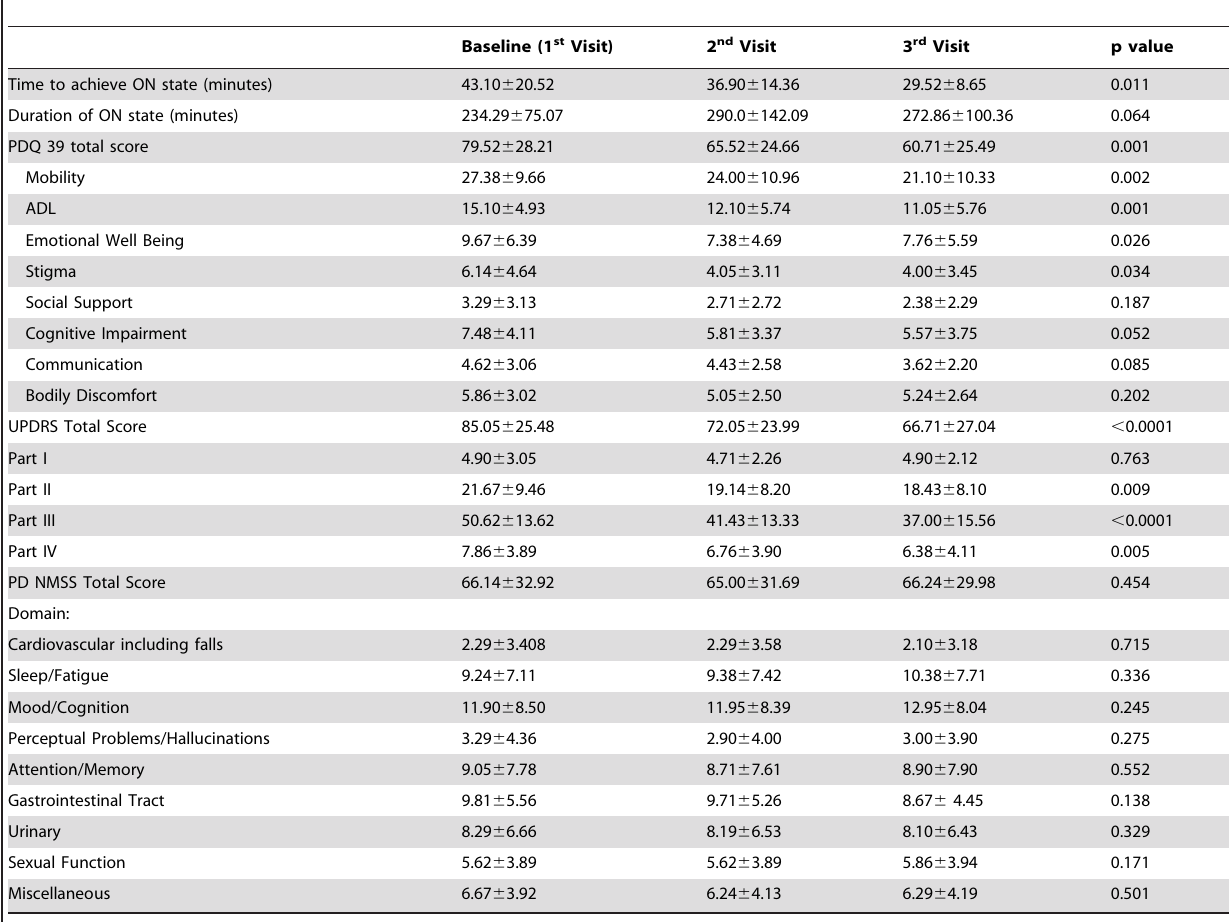
Table 2. Clinical Effects at baseline and following H. pylori eradication therapy (n=